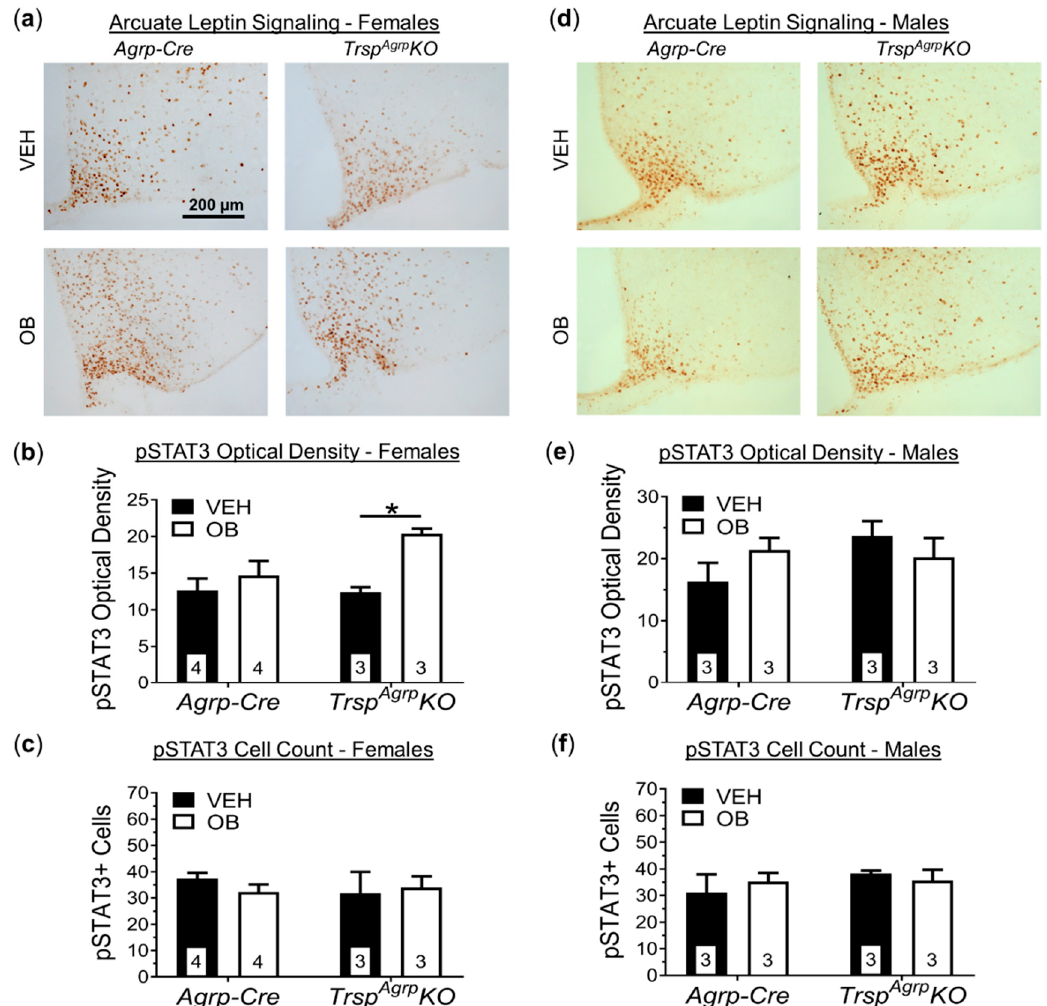
Figure 5. Leptin signaling in brain sections of Trsp Agrp KO mice of both sexes raised on a high-fat diet. Sample images of hypothalamic sections stained for phosphorylated STAT3 (pSTAT3) following in vivo challenge with either vehicle (VEH, saline) or leptin (OB) ( a ). Images are of the medio-basal hypothalamic area containing the arcuate nucleus and were captured at 20× magnification. Optical density of pSTAT3 immunoreactivity, visualized via 3,3 ′ -diaminobenzidine staining, in the arcuate nucleus of female Trsp Agrp KO mice was significantly increased by leptin challenge, but not in Agrp-Cre control mice ( b ) (two-way analysis of variance, followed by Tukey’s multiple comparisons test: * p = 0.03). No change in the number of pSTAT3-positive cells in female Trsp Agrp KO mice was detected ( c ), however. ( d ) Neither genotype nor leptin administration affected pSTAT3 optical density ( e ) or cell count ( f ) in male mice. Samples sizes are displayed in the graphs. All values shown are mean ± standard error of the mean.